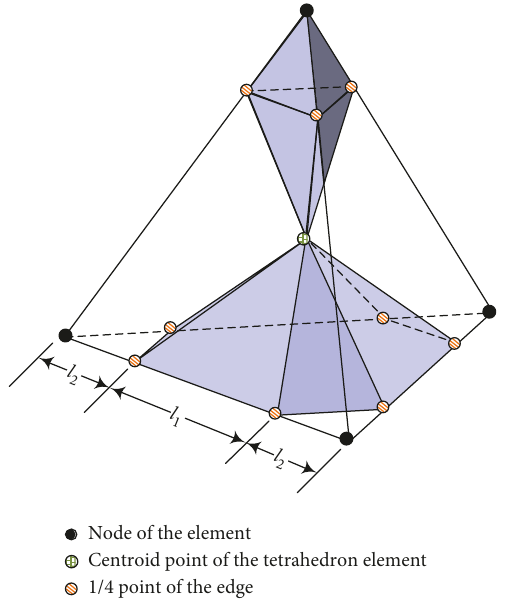
Figure 2: Mixed smoothing domain constructed based on the tetrahedron elements.